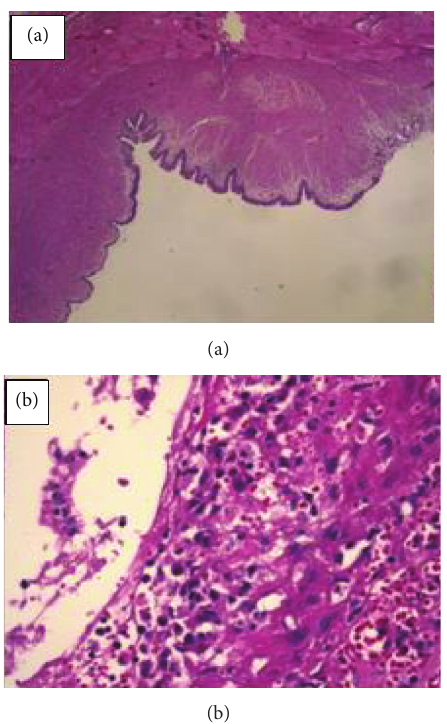
Figure 6: (a) Histopathology of the cyst. (b) High magnification view of the lining